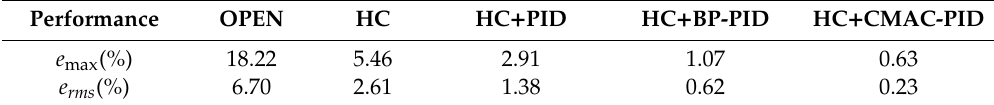
Table 3. Experimental controller performance for the translational motion along X / Y axis.